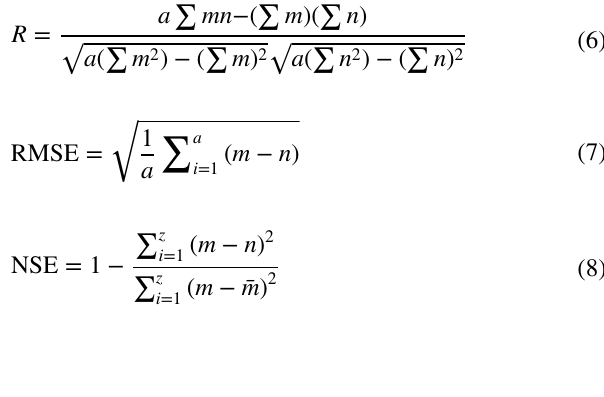
Table 3 Statistical characteristics of experimental data